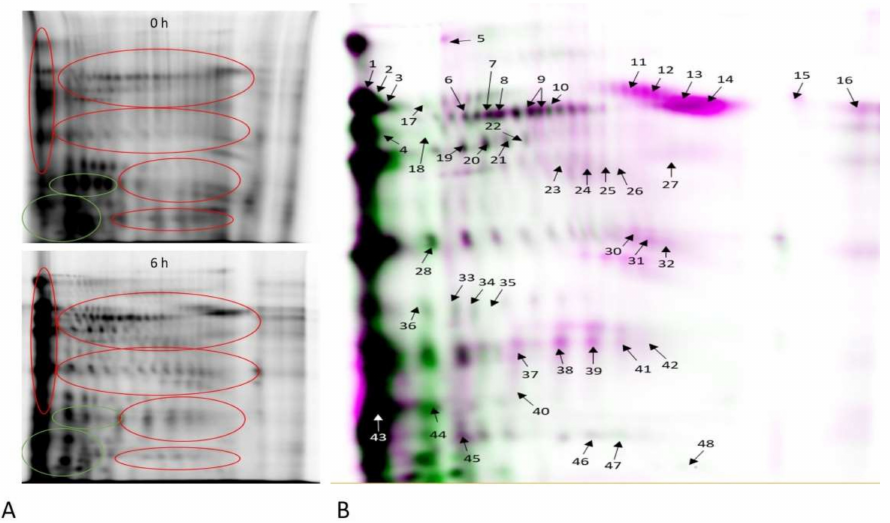
Figure 7. Representative 2D gel images of proteins showing redox changes between 0 and 6 h of incubation in capacitation-supporting conditions ( n = 8). Proteins with reduced cysteines after 6 h of capacitation are marked in green. Proteins with oxidised cysteines after 6 h of capacitation are marked in red ( A ). Representative 2D gel showing redox-modified proteins after 6 h of incubation in capacitation-supporting conditions ( B ). Redox-modified protein spots are listed in Table 1.